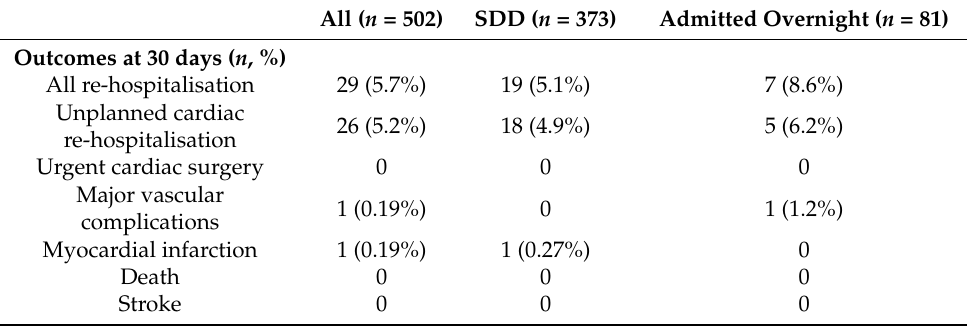
Table 5. Clinical outcomes in elective PCI patients from 2017 to